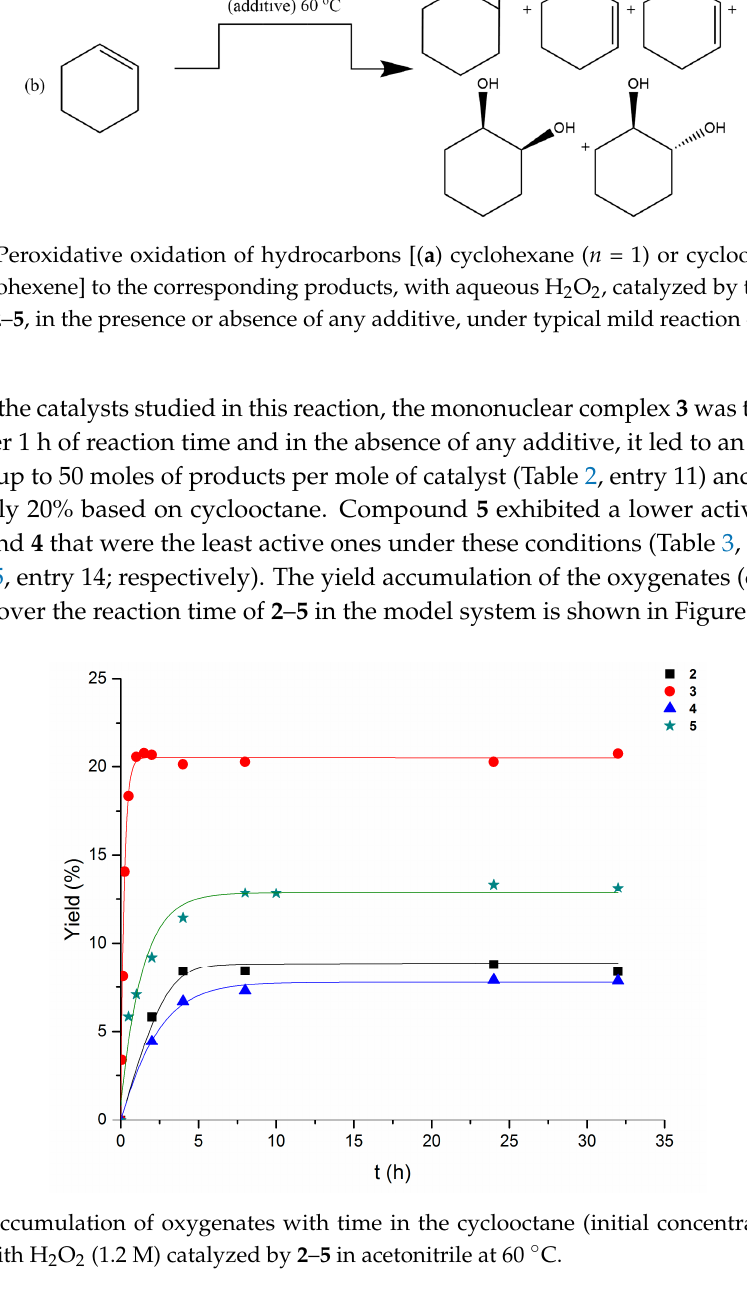
Scheme 2. Peroxidative oxidation of hydrocarbons [( a ) cyclohexane ( n = 1) or cyclooctane ( n = 3) and ( b )